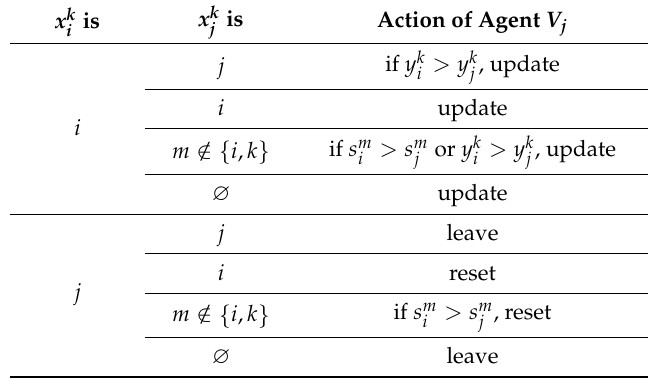
Table 1. Decision rules for agent V j (receiver) upon receiving message from agent V i (sender). x k i